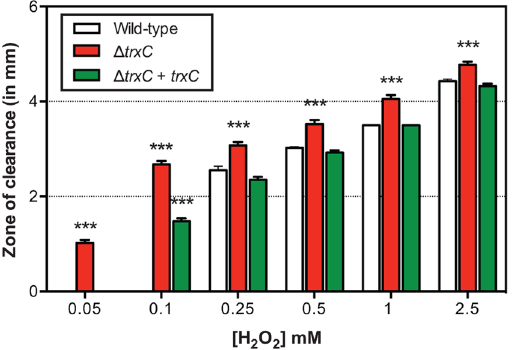
Figure 6. Sensitivity to hydrogen peroxide of C . jejuni M1cam wild-type, trxC defined gene deletion mutant and trxC complemented mutant. Data shown are zones of inhibition and plotted as means with SEM ( n ≥ 4). Statistical significance was analysed using a two-way ANOVA test with *** P <